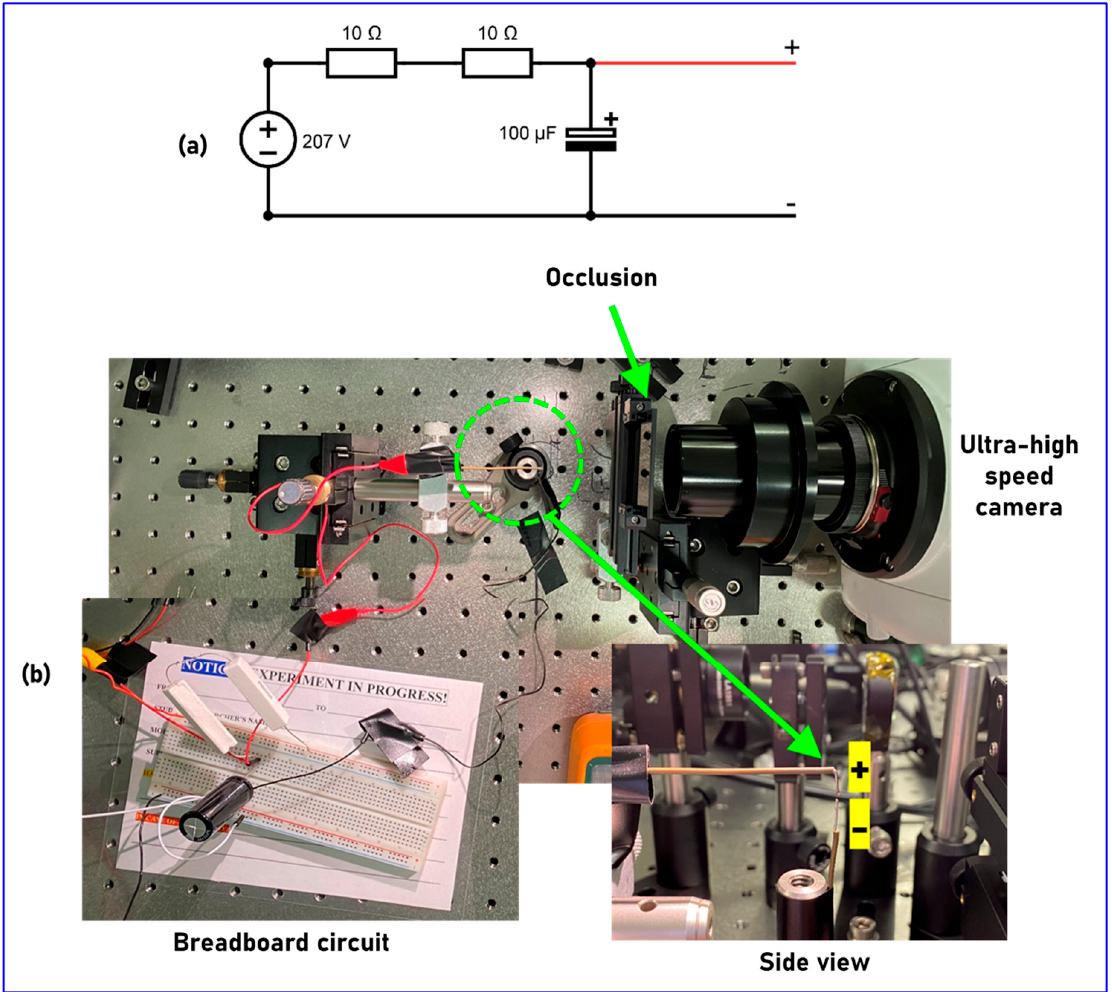
Figure 5. ( a ) Circuit diagram for generating a spark. ( b ) Photograph of the experimental set up. A spark event was generated using ( a ) at a distance of 5 cm from the occlusion and an ultra-high-speed camera was mounted at a distance of 15 cm from the occlusion.